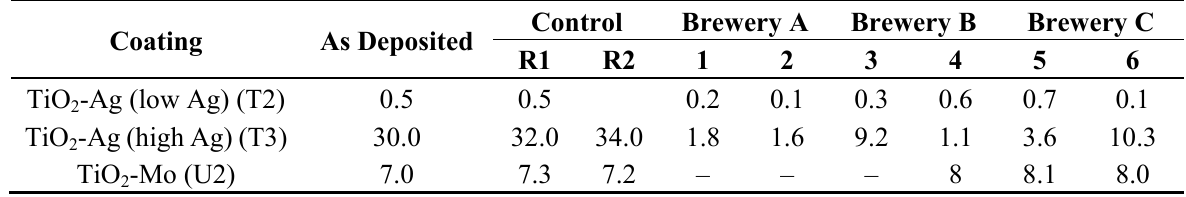
Table 3. Concentration of dopant as analysed using EDX (error in the measurements was ±10%). Control Coating As Deposited